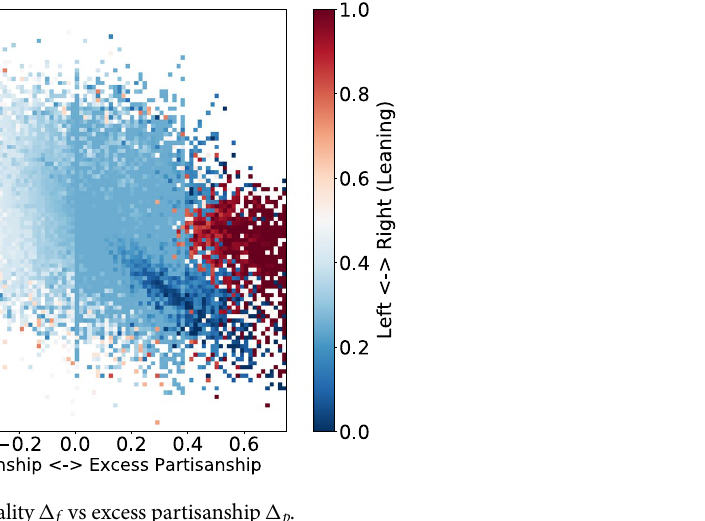
Figure 4 shows the joint distribution of excess partisanship (cid:31) p and excess factuality (cid:31) f . The negative cor- relation (Pearson’s correlation r = − 0.38 , p < 0.001 ) between the two dimensions suggests that not only do politically hardline social media users (regardless of whether they are liberal or conservative) have a higher propensity for misinformation, but users who amplify politically polarized content also amplify misinforma- tion. The color shows partisanship. Interestingly, both hardline conservatives and hardline liberals are active in amplifying partisanship � p > 0 and misinformation � f < 0 , with liberals playing a more active role in amplify- ing misinformation. On the other hand, users who are less partisan than their friends ( � p < 0 ) also share more factual information than what they are exposed to ( � f > 0 ). By filtering out misinformation, such users play an